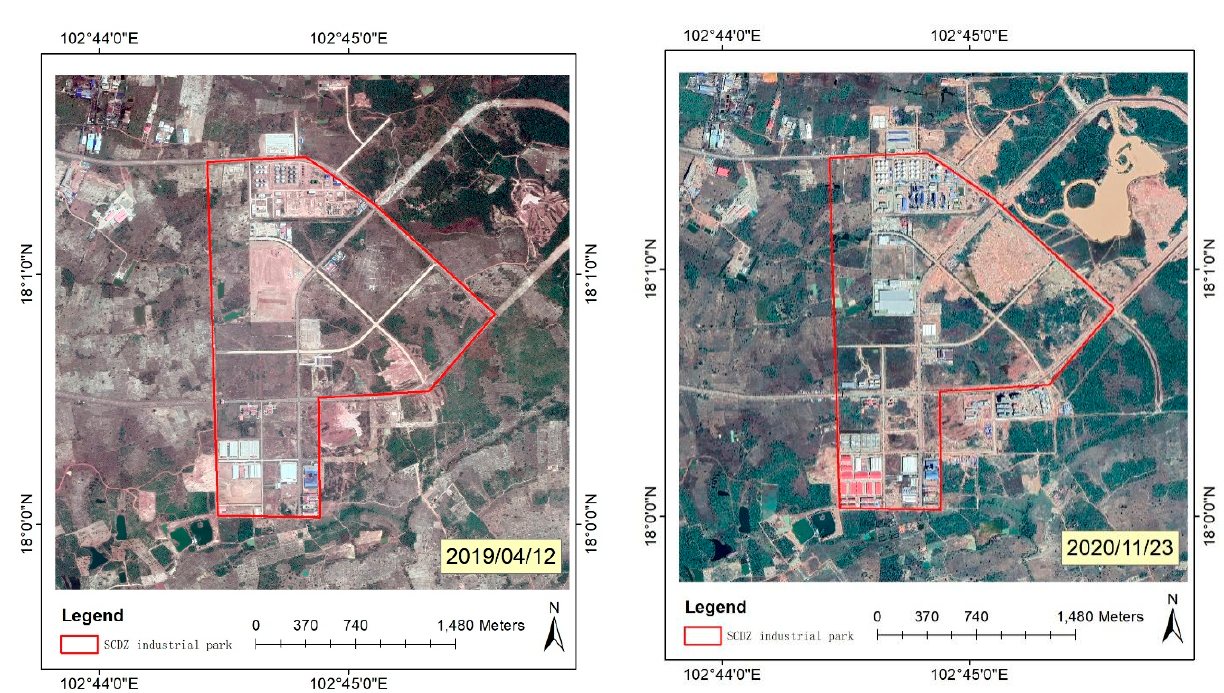
Figure 5. 0.5 m remote sensing image of SCDZ acquired on 12 April 2019 and 23 November